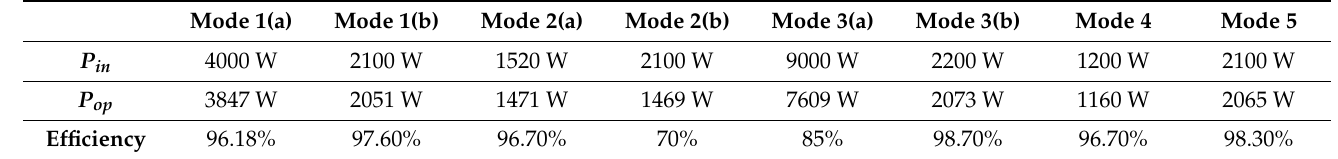
Table 8. The efficiency of the converter of the five operation